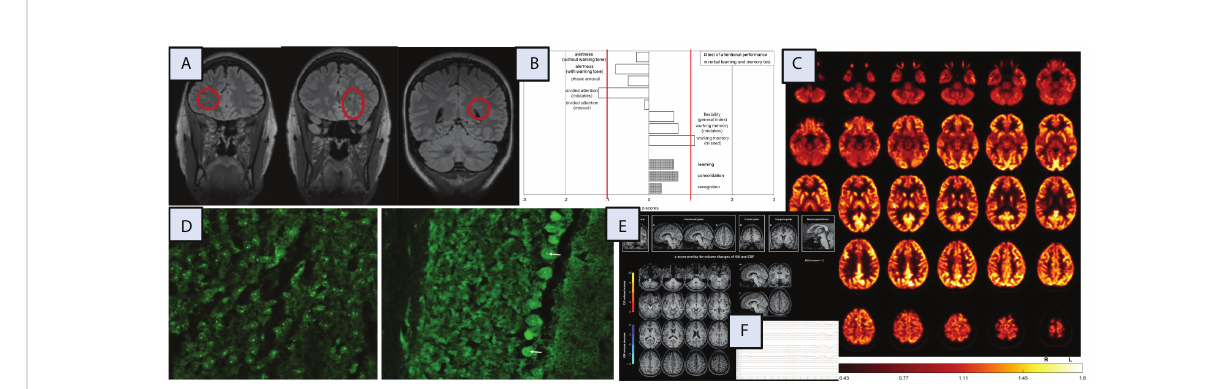
FIGURE 1 Magnetic resonance imaging (MRI), neuropsychological, [ 18 F] fl uorodeoxyglucose positron emission tomography (FDG-PET), cerebrospinal fl uid (CSF), and electroencephalography (EEG) fi ndings. Additional investigations, including independent component analysis of the EEG and optical coherence tomography, identi fi ed no speci fi c changes (data not shown). CSF, cerebrospinal fl uid; GM, grey matter, L, left; R, right; ROI, region of interest. (A) MRI demonstrated multiple punctate FLAIR hyperintense white matter lesions, predominantly subcortical changes. (B) The neuropsychological testing, including a test battery for attention performance ( “ TAP ” ) and the verbal learning and memory test ( “ VLMT ” ) identi fi ed mostly normal results, only the divided attention showed below average fi ndings. (C) FDG-PET of the brain showed normal fi ndings. The globally normalized FDG image is shown. FDG-PET of the whole body showed no evidence of tumor (not shown). (D) Autoantibody staining using tissue-based assays on murine brain identi fi ed highly positive autoantibodies against nucleoli in CSF (left in cortex, right in cerebellar Purkinje cells [arrows]). (F) A combined volume-based and region-based analysis method using the MPRAGE MRI images identi fi ed no atrophic changes (https://www.veobrain.com/?page=veomorph). (E) EEG detected normal fi